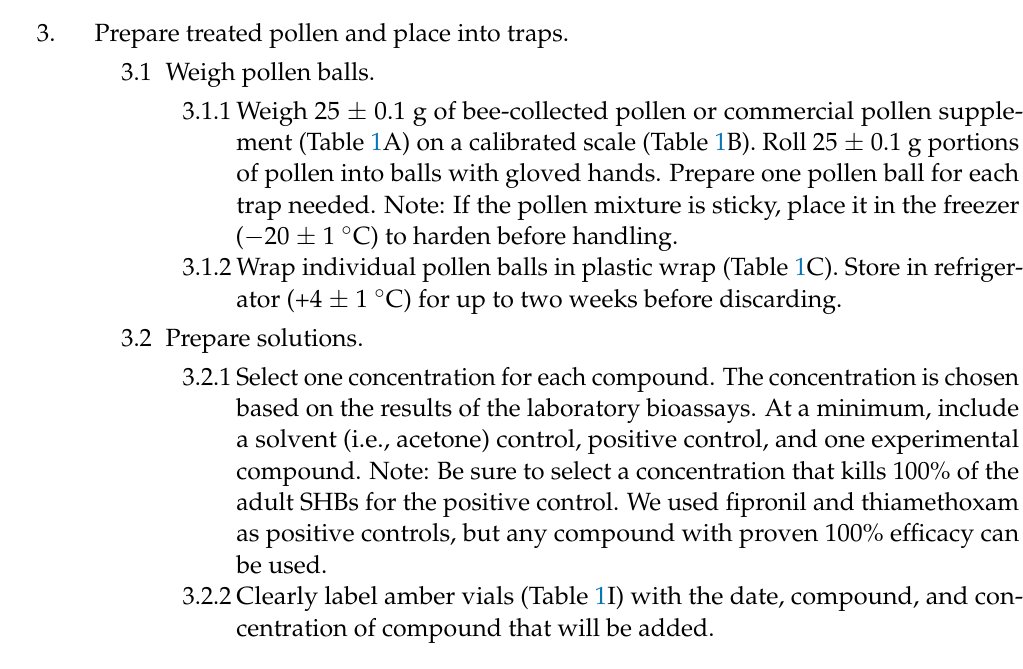
Figure 2. Trap design used in the field trial. The CD cases were modified by cutting a 3.5 cm entrance on 3 sides (denoted by *) to allow small hive beetles access to treated pollen inside the cage.